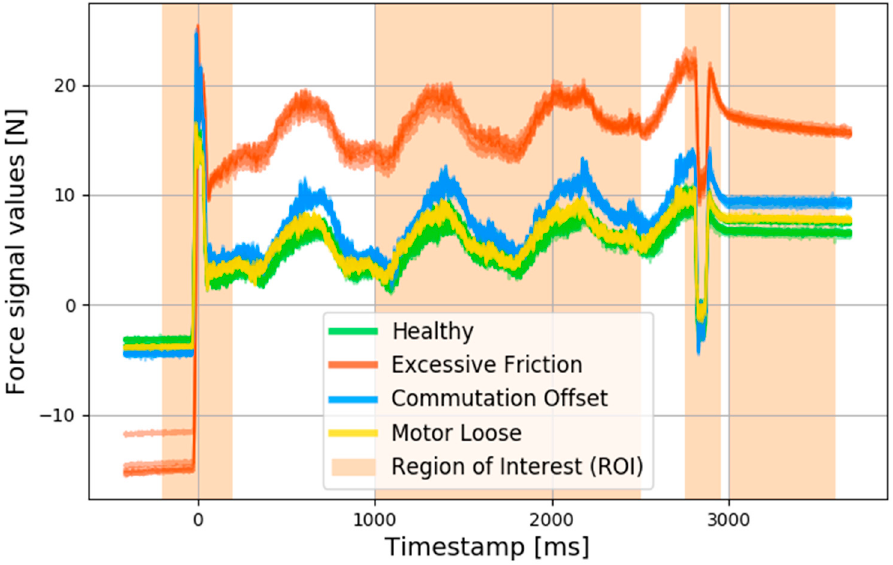
Figure 2. Force signal data of (+) direction test cycle of training samples.